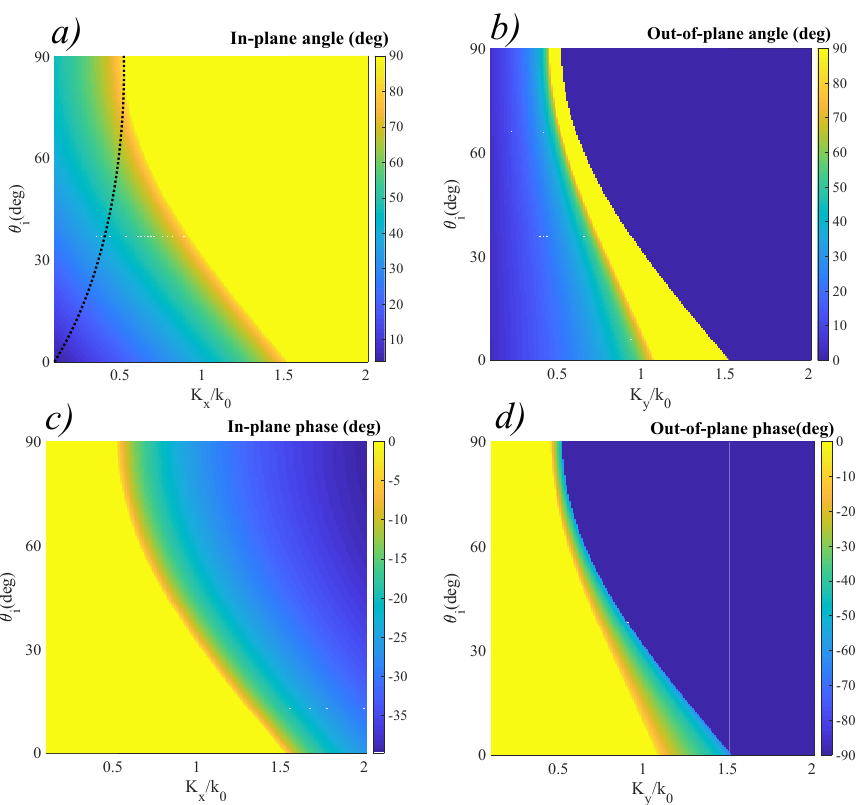
Figure 4. Transmission properties of a linear-gradient optical interface. ( a ) In-plane transmission angle θ t obtained for a metasurface with a constant positive gradient K x across the Ox direction. The dotted line represents the tuning curve to achieve equal angles of incidence and emergence at non-normal angles. ( b ) Out-of-plane transmission angle ϕ t for a metasurface with a positive linear gradient K y across Oy . ( c ) Associated phase of the transmitted wave for the K x − defined metasurface. ( d ) Associated phase of the transmitted wave for the K y − defined